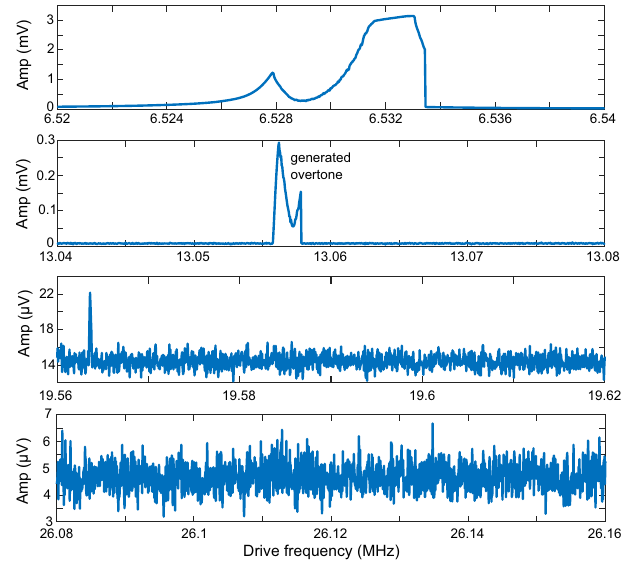
FIG. 7. Frequency response measurement in the RIFF regime (drive power 0 dBm), sweeping the drive frequency through the eigenfrequency of the OOP mode. The four lines show the response of the sample at the drive frequency, as well as at 2, 3, and 4 times its